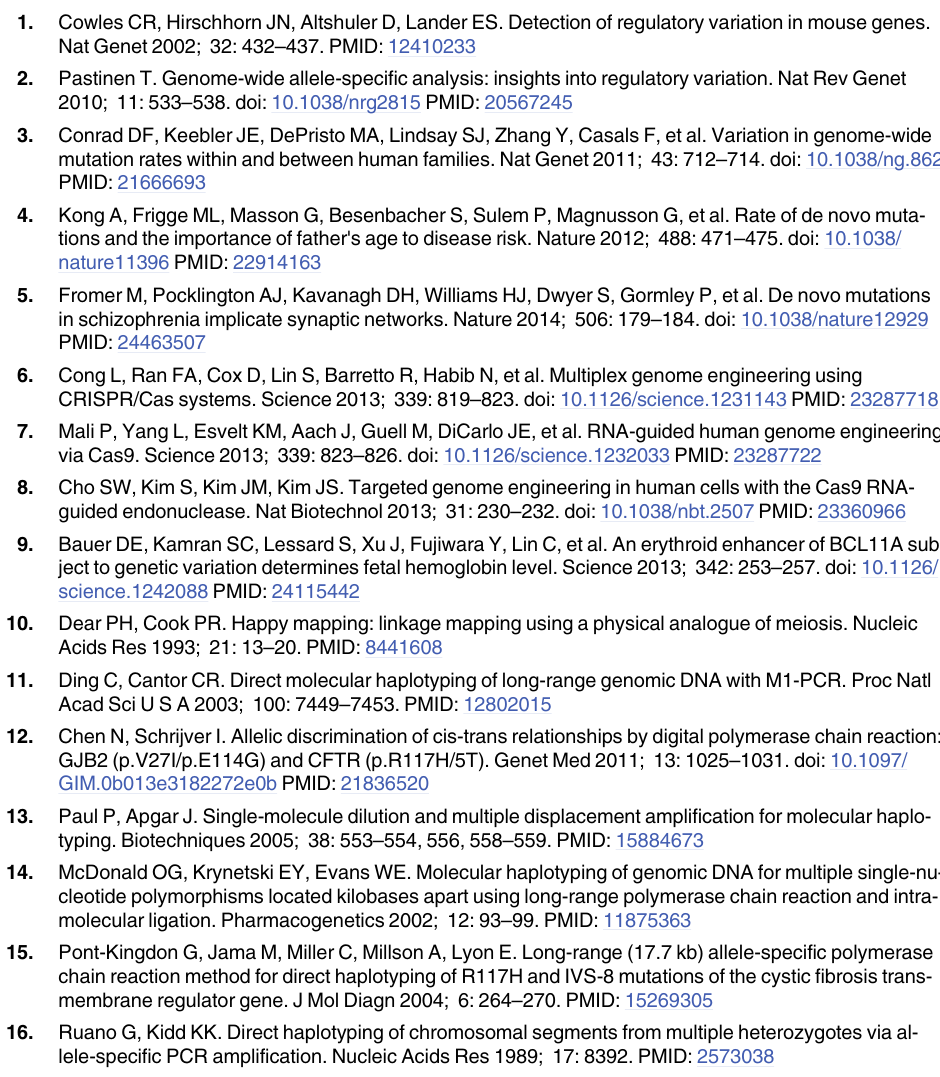
S1 Table. Assays used to assess physical linkage as a function of genomic distance. S2 Table. Assays used to analyze CFTR . S3 Table. Laboratory costs associated with